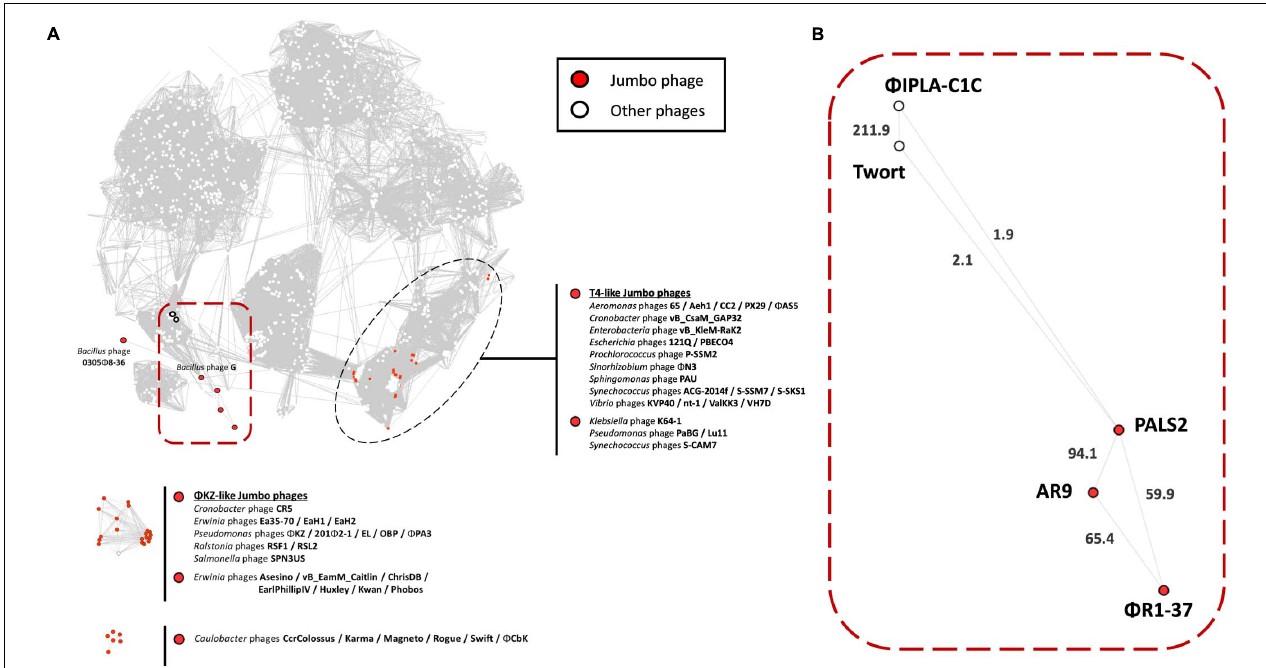
FIGURE 6 | Protein-sharing network of phage PALS2. (A) A network representation was produced using Cytoscape. Nodes indicate phage genomes, and edges between two nodes indicate their statistically weighted pairwise similarities with phage–phage similarity scores of ≥ 1. Nodes are colored according to the phages’ characteristics: jumbo phage, red; other phages, white. Jumbo phages were further labeled with their designated names. On the top is the largest subnetwork that contains the largest number of phage genomes, including jumbo phages from the T4-like clade. The other subnetworks below are the smaller clusters of jumbo phages and their relatives that were disconnected from the largest subnetwork. Phage PALS2 and its first neighbors are situated in the large subnetwork, which is highlighted with a red square boundary. (B) Enlarged view of phage PALS2 and its relatives. Edge length is proportional to the similarity values estimated with the hypergeometric equation. The values are written on top of each edge. The data indicate that PALS2 is closer to jumbo phages AR9 and phiR1-37 than to the staphylococcal phages Twort and phiPLA-C1C.